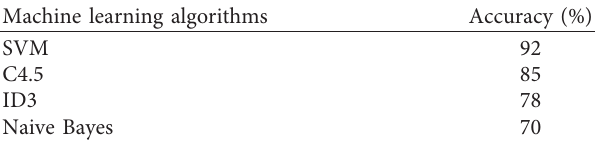
Table 2: Accuracy results of classification